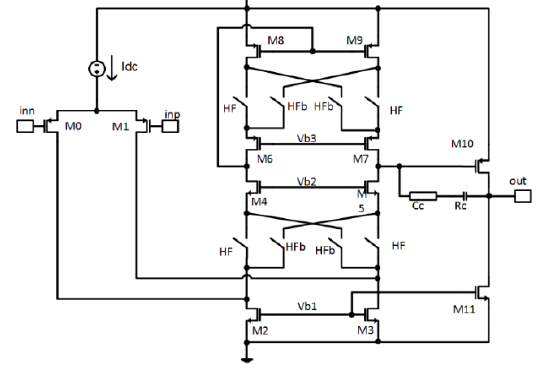
Figure 11. Simplified circuit diagram of the amplifier of the first CT integrator with HF chopper switches